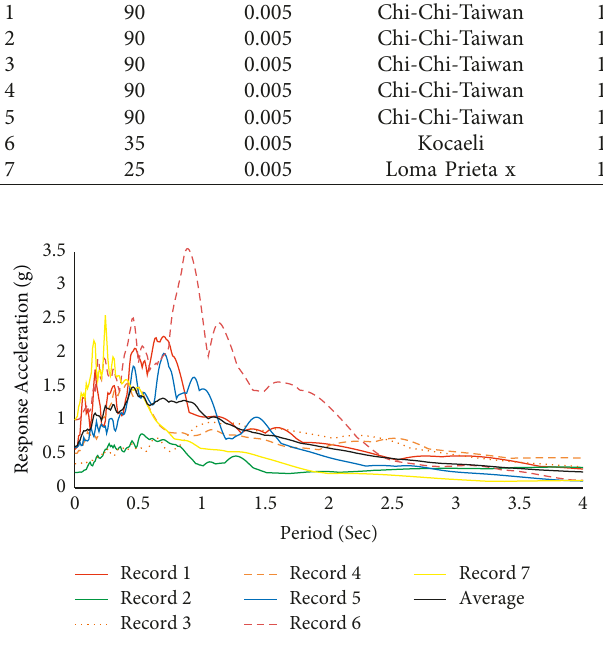
Figure 31: Acceleration response spectrum of selected records and their average. Table 9: Summarized capacity of the unbraced portal frame for immediate occupancy (IO) limit state.